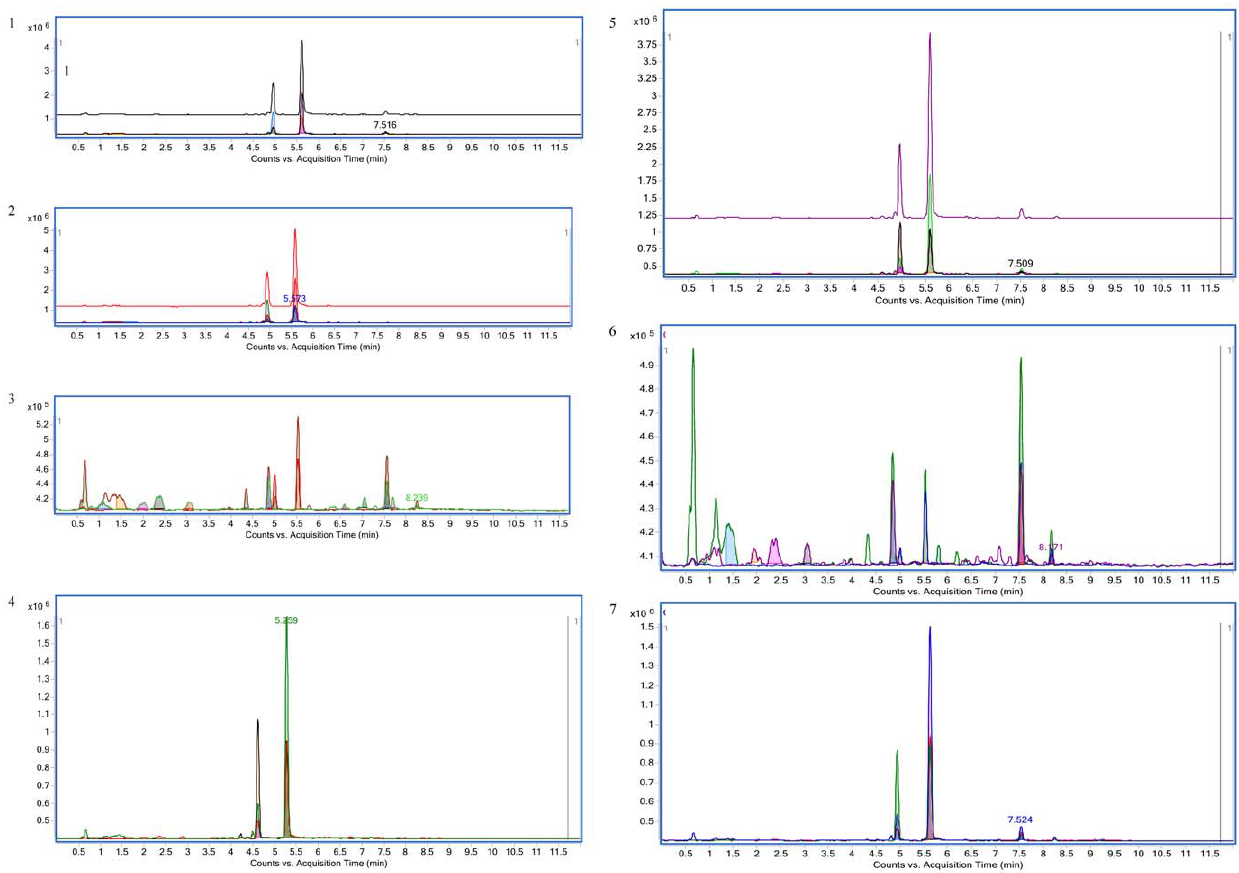
Figure 4. MS profiles of AHL signals. An Agilent 6520 LC-ESI-QTOF in full scanning positive ion mode or auto-MS/MS mode in a range of 50– 1600 m/z was used. TIC trace of each sample (1, 11, 53, 54, 93, 102, 117) with overlaid common precursor ions are respectively shown in figures 1, 2, 3, 4, 5, 6 and 7. Each of the peaks was then analyzed by MS to identify the parent ion, and the full MS profile for each ion was established to identify the exact chain lengths of the